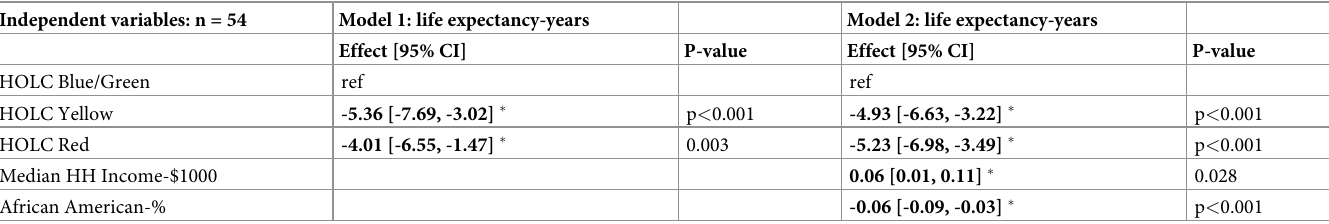
Table 2. Multivariable ordinary least squares analysis of Baltimore HOLC and 2013 life expectancy.